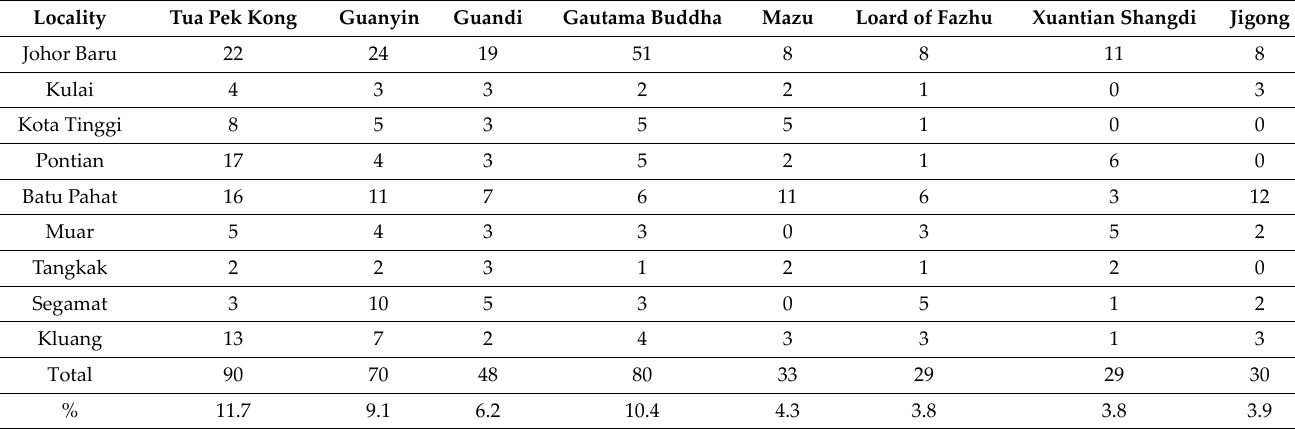
Table 12. Main Deity and Their Distribution in Each District